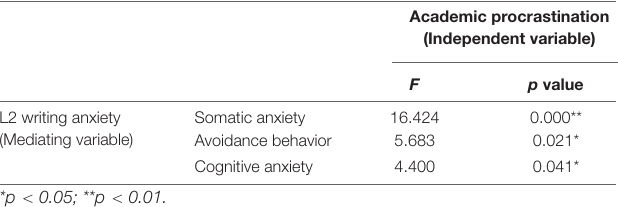
TABLE 1 | The impact of academic procrastination on L2 writing anxiety: regression analysis.